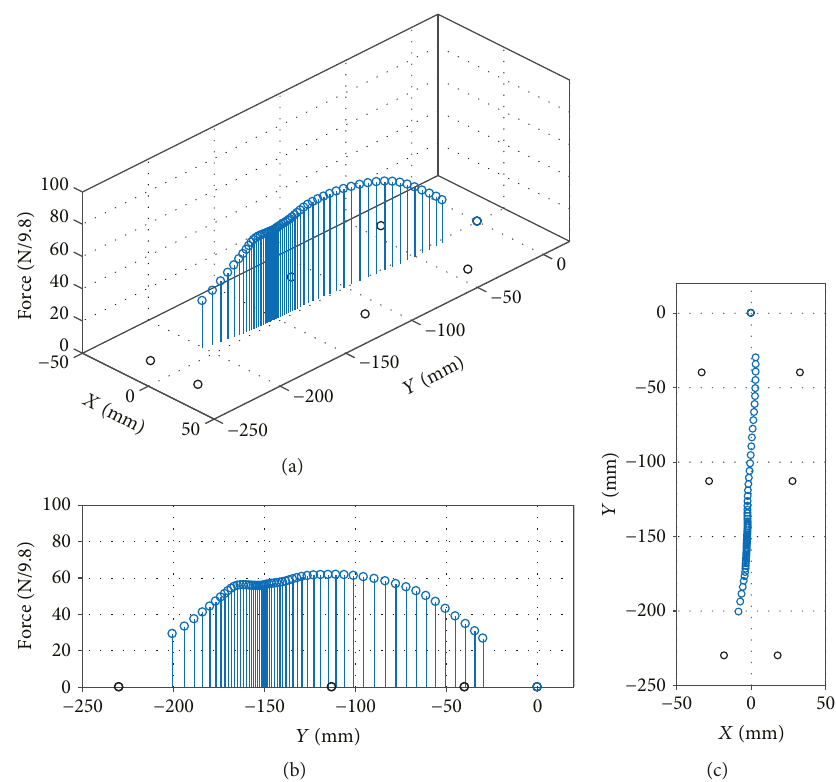
Figure 6: The CoP for the left foot; the black circle denotes the pressure-bearing point. (a) The trajectory of the CoP. (b) The magnitude of the total force during contact of the left foot to the ground. (c) The trajectory of CoP when the heel touches the ground up to point when the toe lifts from the ground.